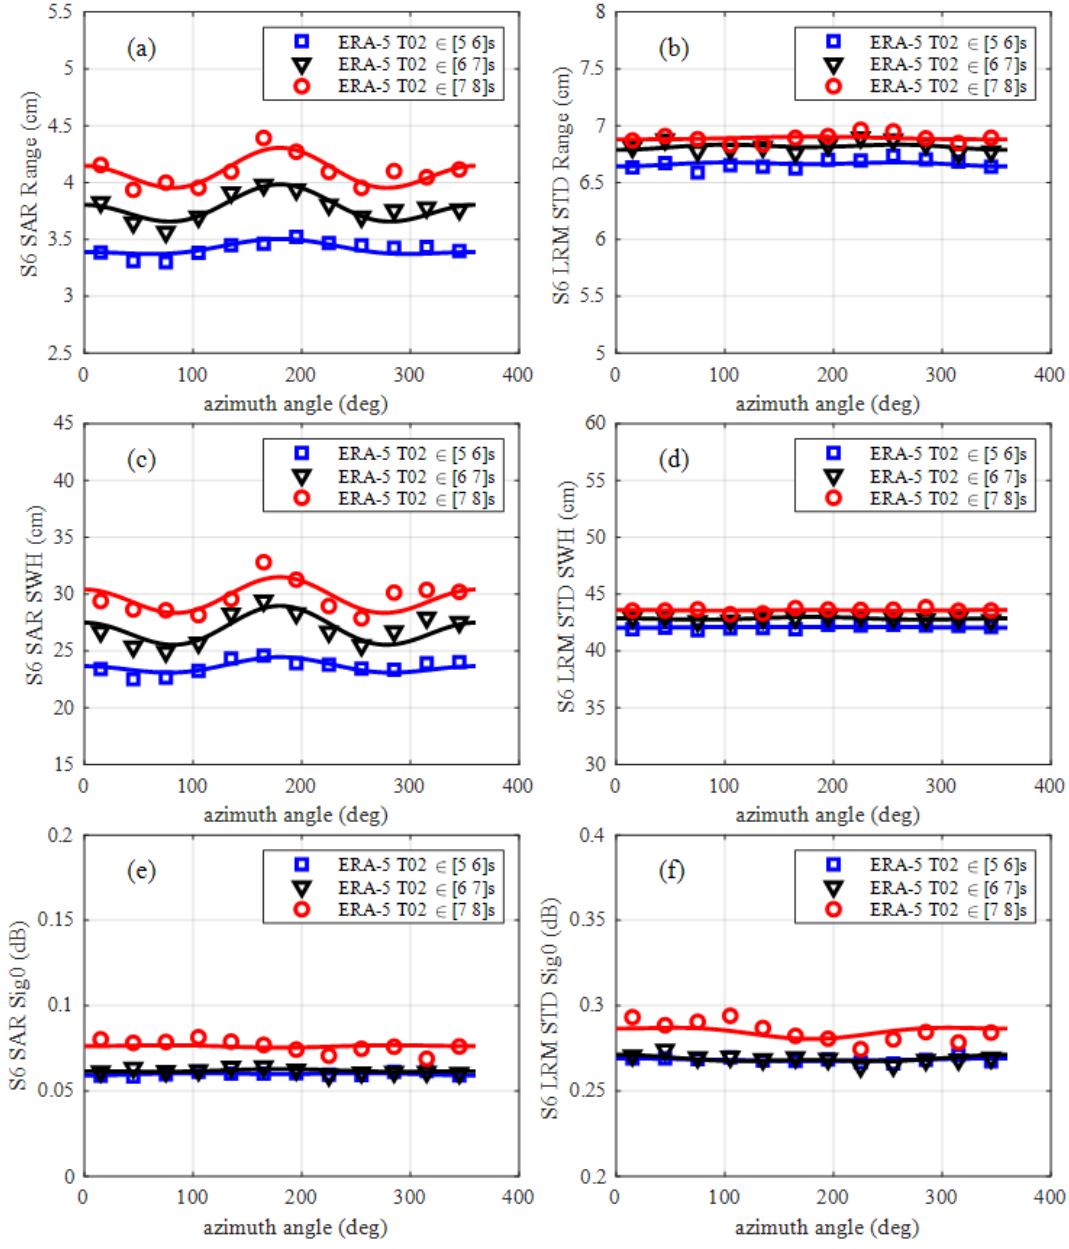
Figure 20. STD s of 20 Hz Sentinel-6 SARM ( left ) and LRM ( right ) range, SWH and sigma0 against ERA5 SWH estimates for different relative azimuth direction and T02